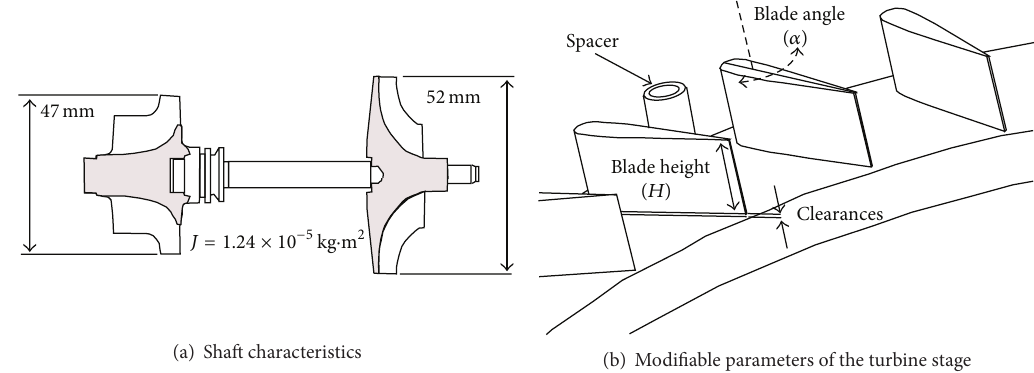
Figure 3: Illustration of the geometric characteristics.